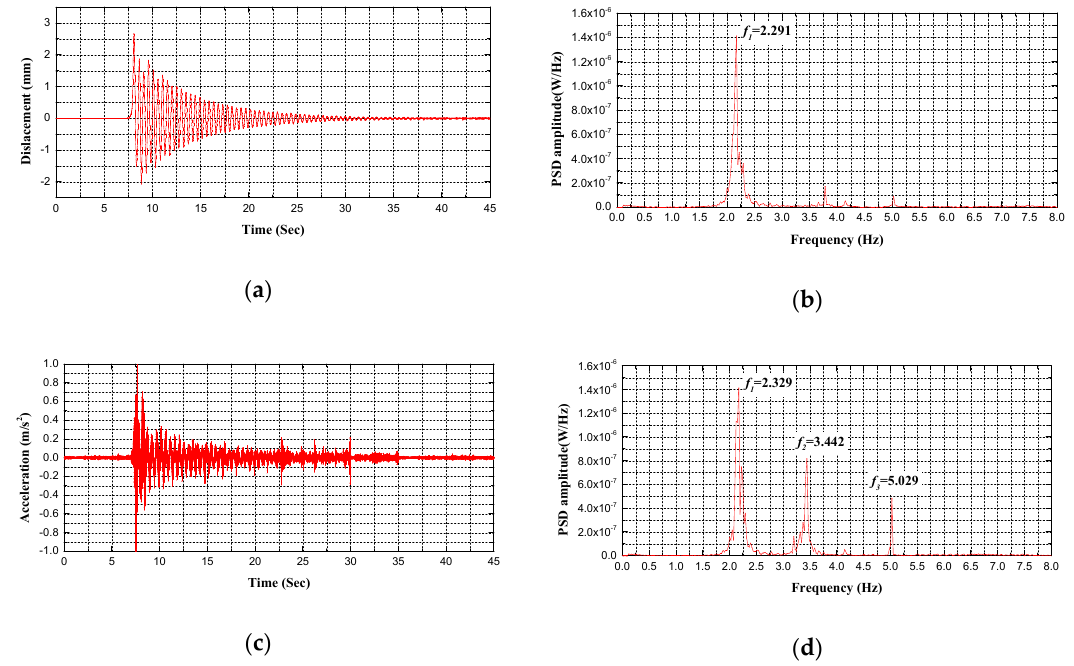
Figure 15. Comparison between measured frequencies for B2 test condition: ( a ) displacement response measured by HVS; ( b ) the PSD of displacement response measured by HVS; ( c ) acceleration signal measured by accelerometer; ( d ) the PSD of acceleration signal measured by accelerometer.